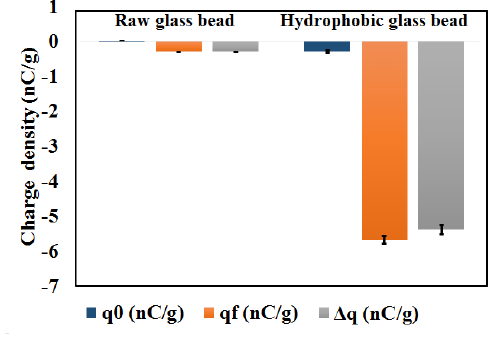
Figure 4. The evolution of electrostatic charge of raw and hy- drophobic glass beads before and after flowing inside V-tube. The measurement performed by GranuCharge equipment. The humidity and temperature range are 37-44 % and 22 ◦ C, respec-